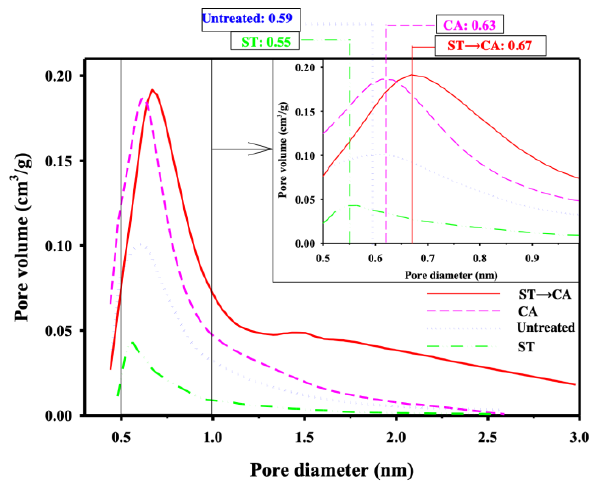
Figure 4. Pore size distribution of ACFs before and after surface treatment and chemical activation